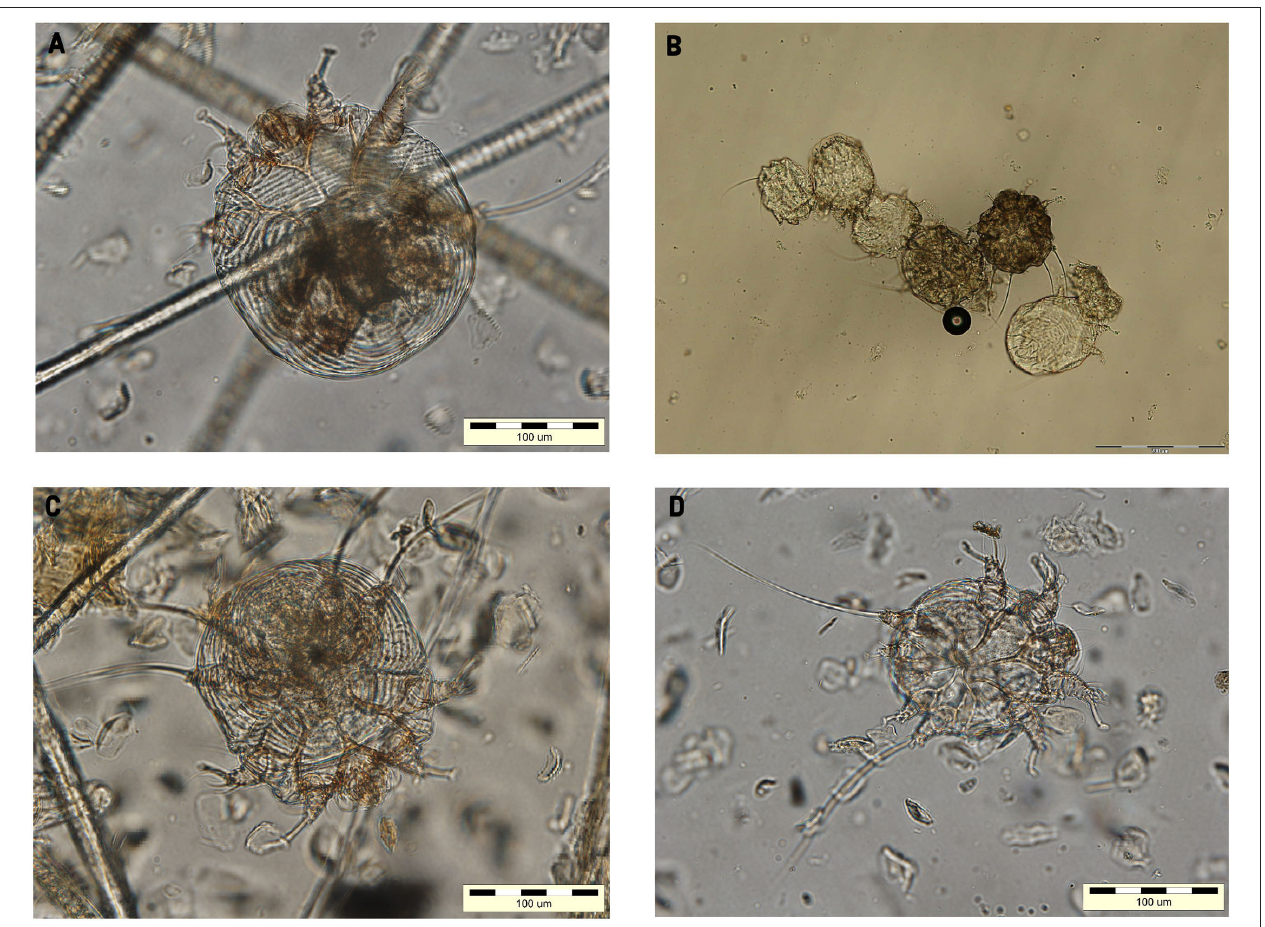
FIGURE 3 | Notoedres cati (x100) identified through skin scraping (A,C,D) and flotation (B)